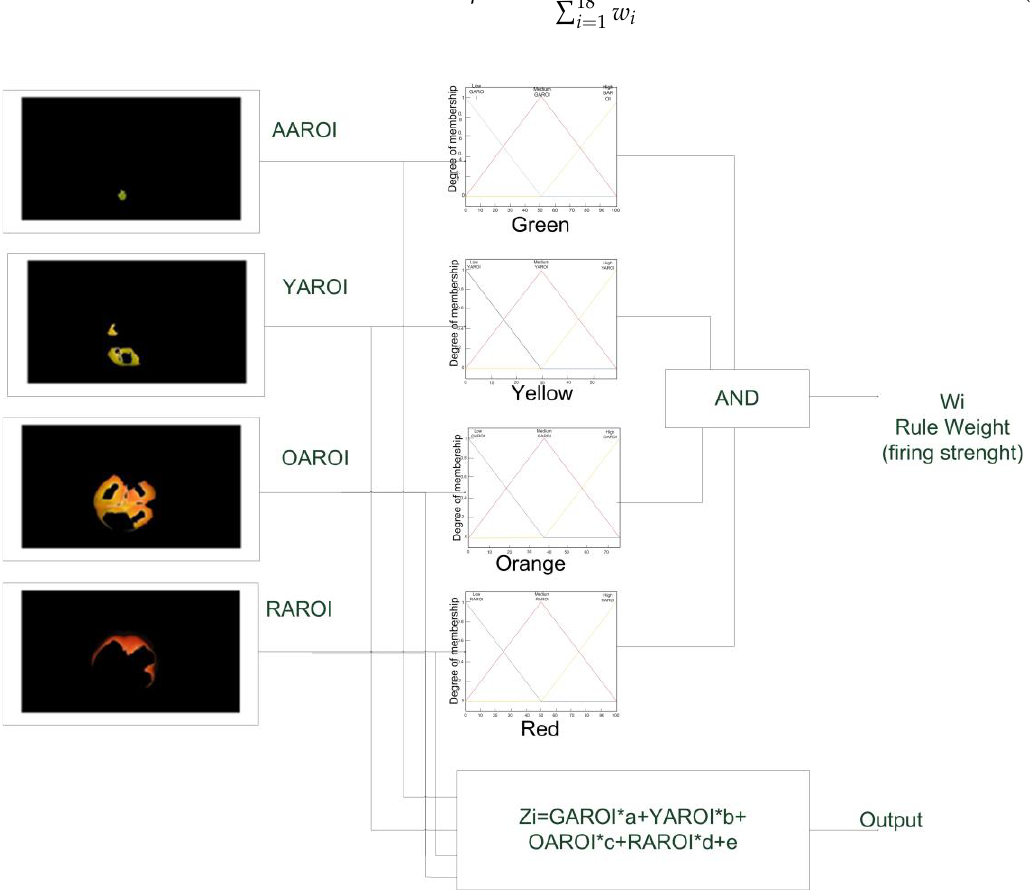
Figure 15. Operation of Takagi–Sugeno rules to classify maturity of bell